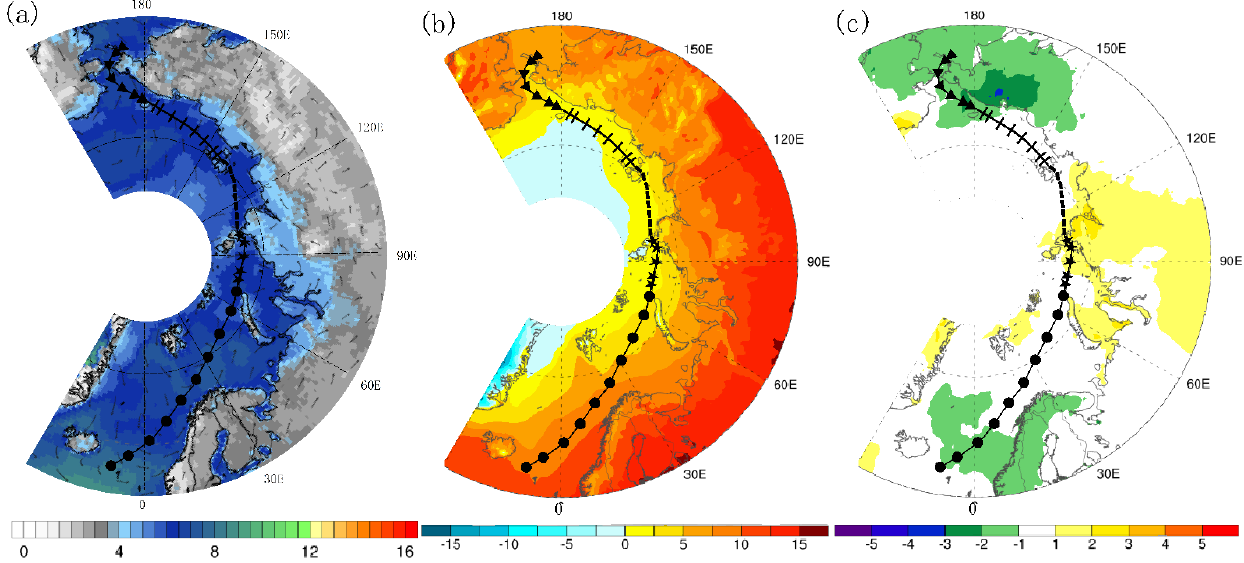
Figure 19. The average wind field ( a ), sea ice age ( b ) and sea ice movement ( c ) of the NEP in the Arctic in September 2013.